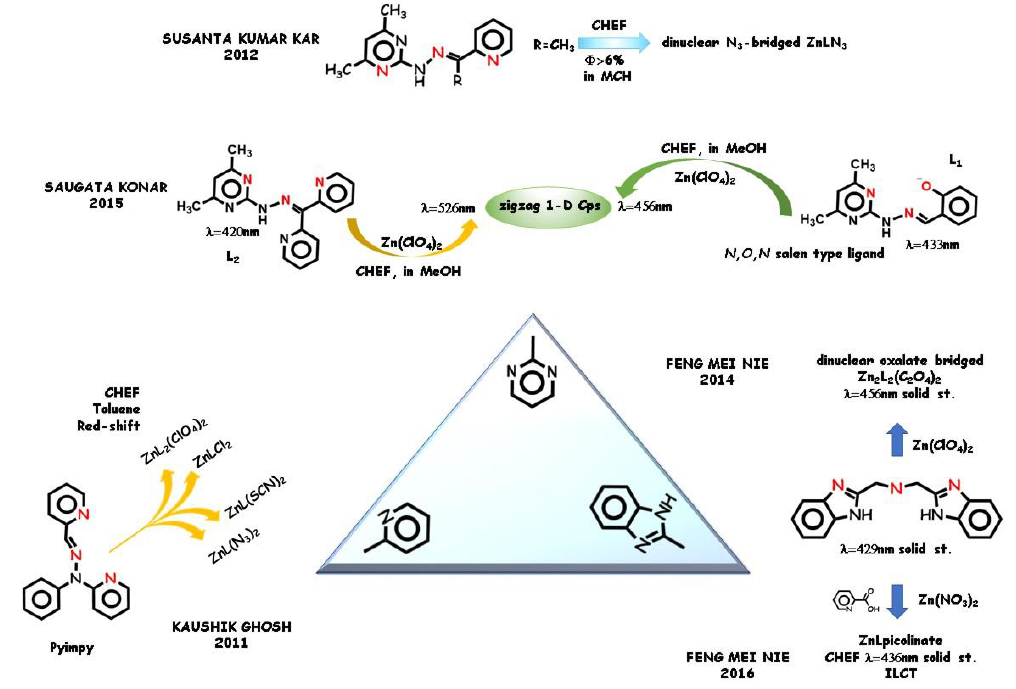
Figure 4. N , N , N Schiff base-type ligands with different nitrogen aromatic rings and their CHEF active complexes.